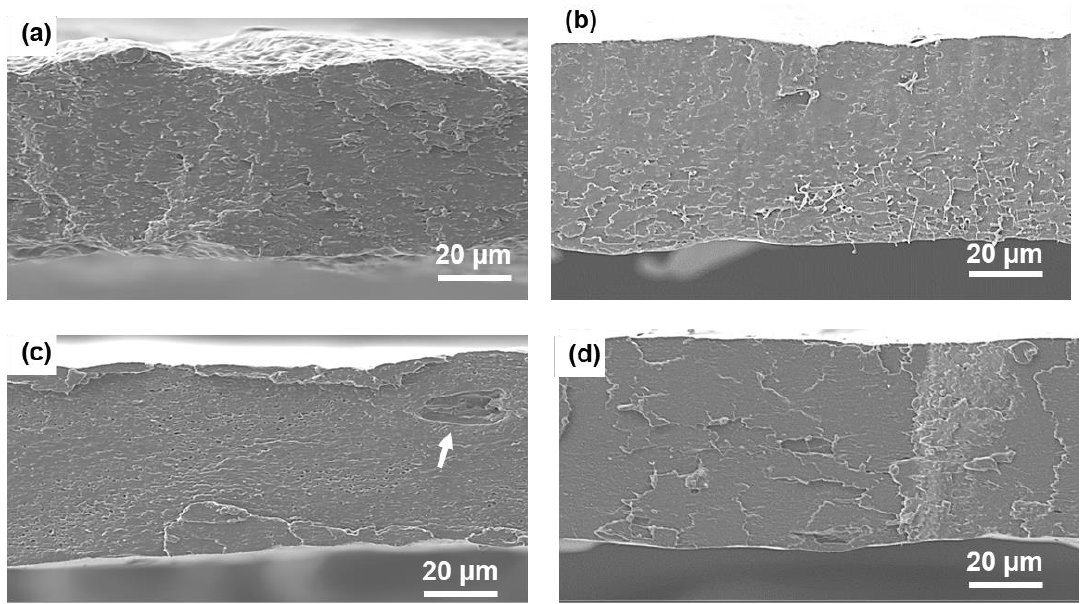
Figure 3. SEM images of the cryo-fractured surfaces of ( a ) PLA-PHB, ( b ) PLA-PHB-OLA, ( c ) PLA- PHB-OLA-CNC, and ( d )